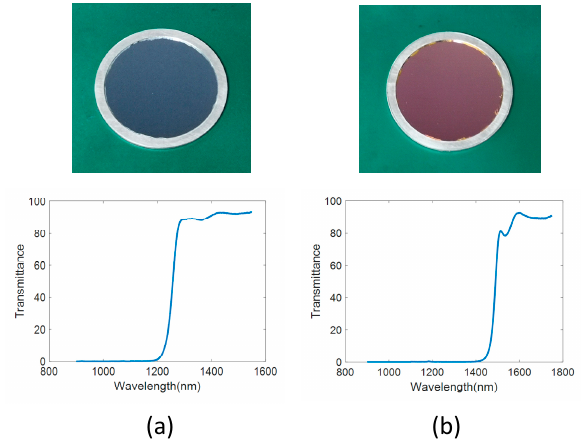
Figure 10. Transmittance of filters ( a ) 1.3 um filter ( b ) 1.5 um filter.